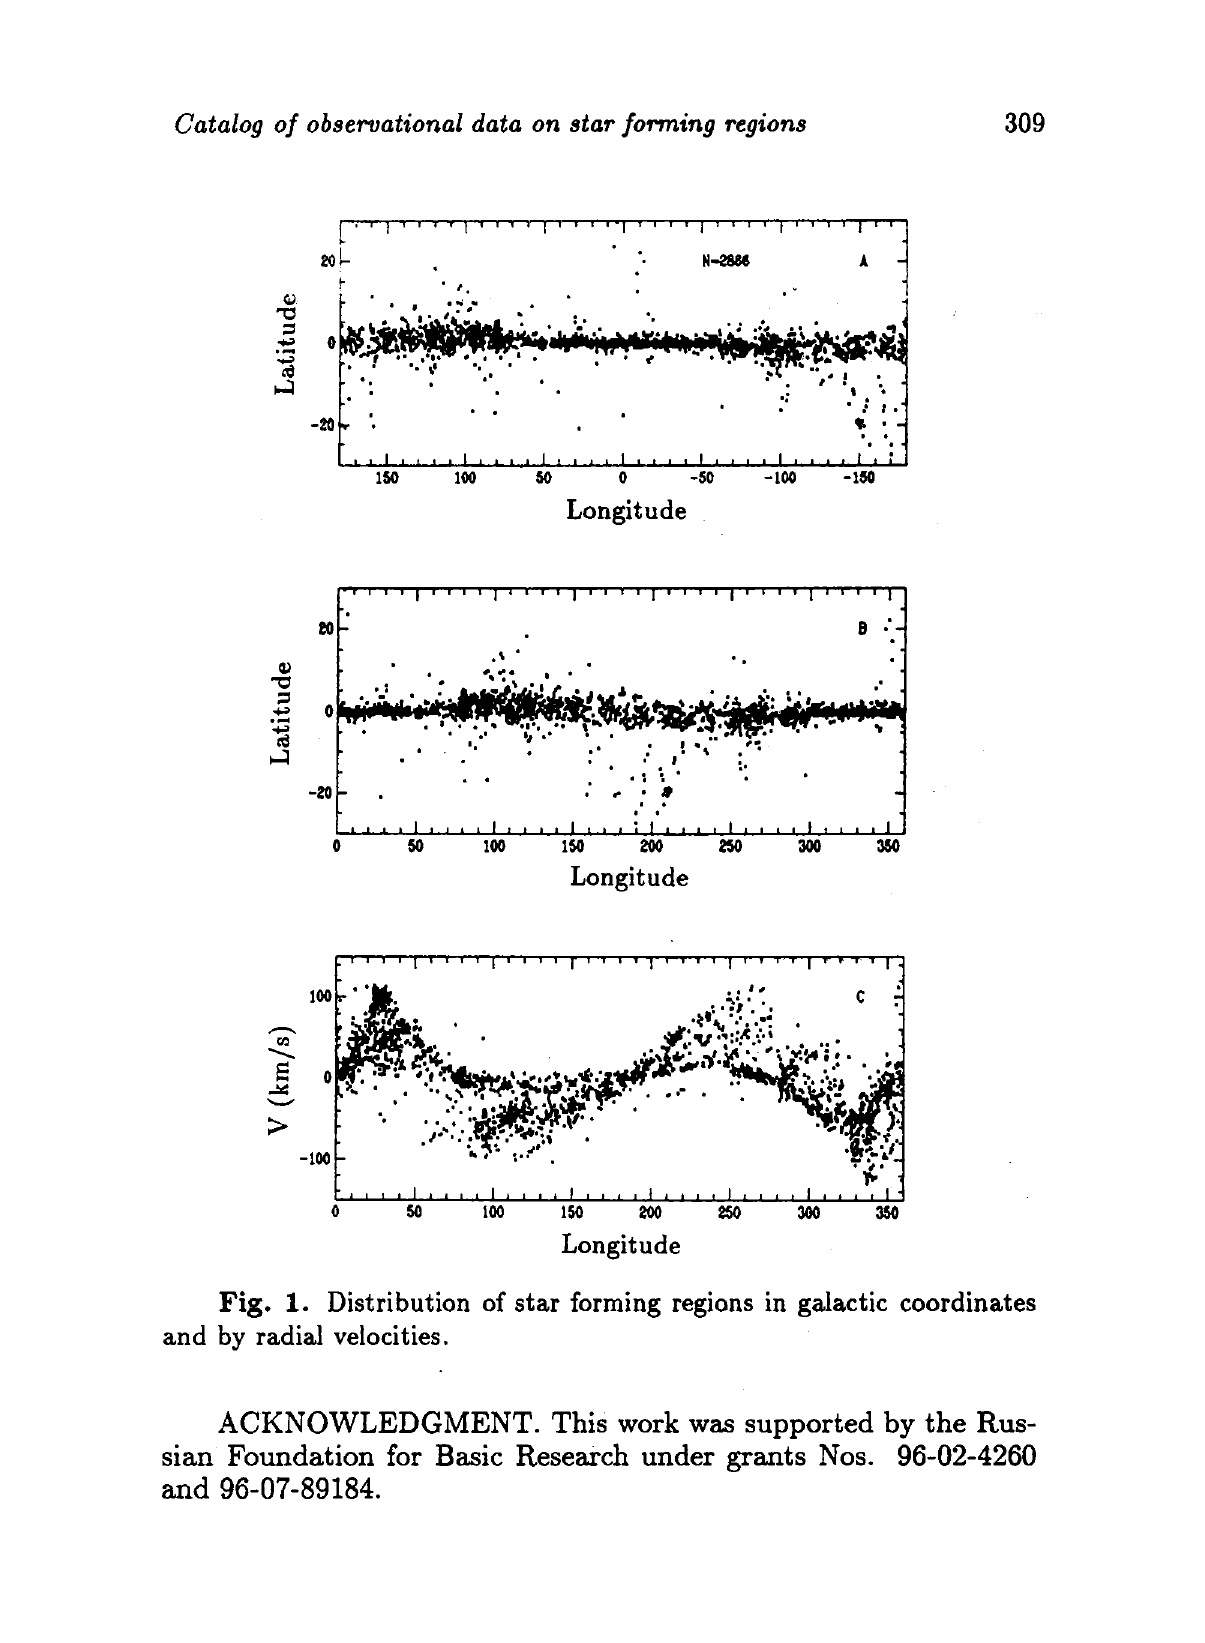
Fig. 1. Distribution of star forming regions in galactic coordinates and by radial